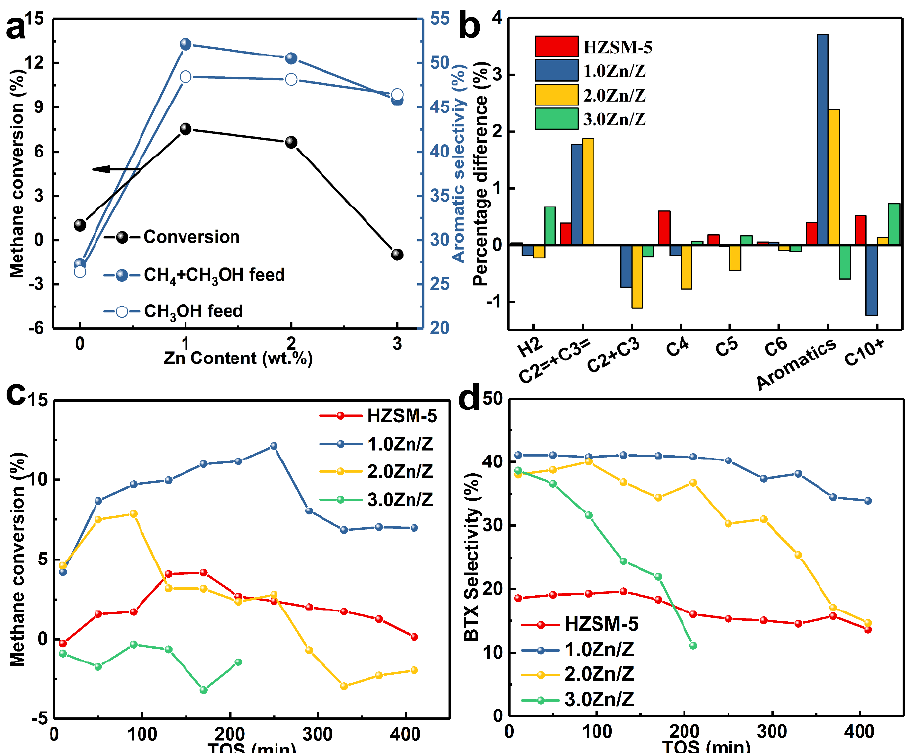
Figure 2. Methane conversion and BTX selectivities of MTA and co-reaction over HZSM-5 and Zn-modified ZSM-5 zeolites (0.67 g catalyst, 37.1 mL·min −1 N 2 flow rate in MTA reaction or 37.1 mL·min −1 mixed gas of N 2 and CH 4 , 0.045 mL·min −1 methanol flow rate, the methanol to methane